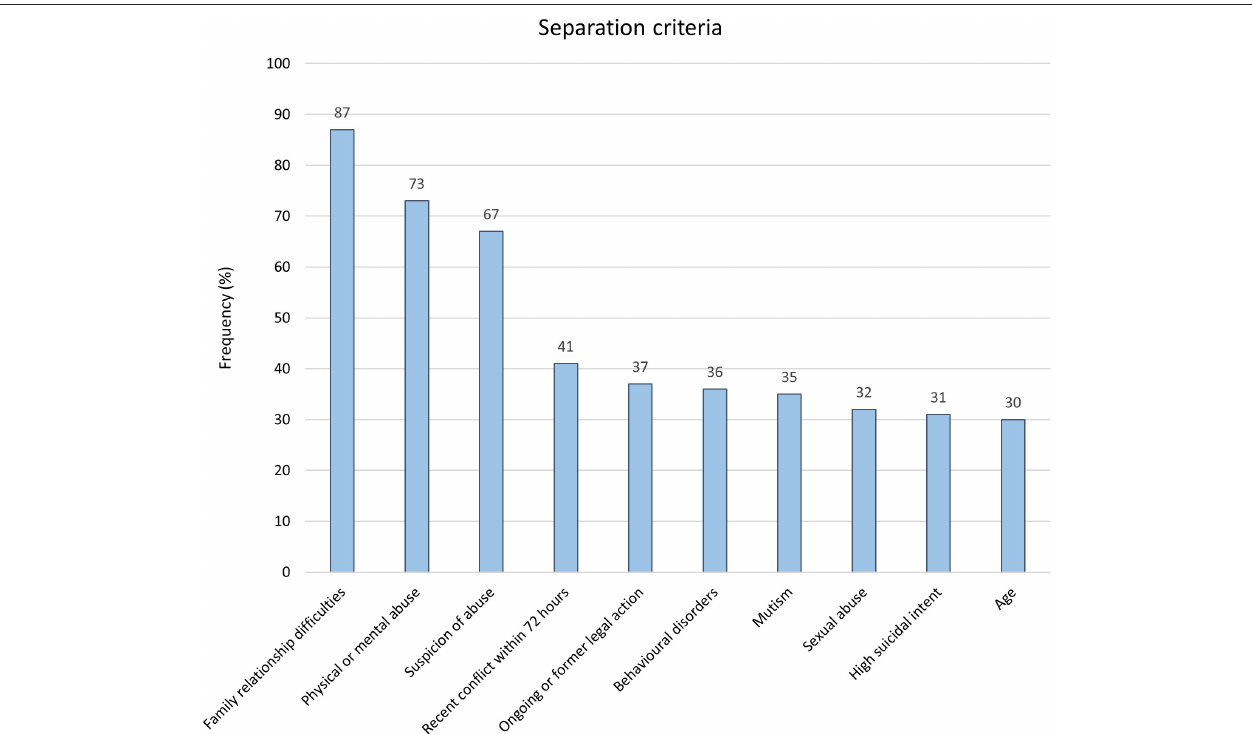
FIGURE 2 | Ten most commonly cited separation criteria used to indicate a separation protocol.